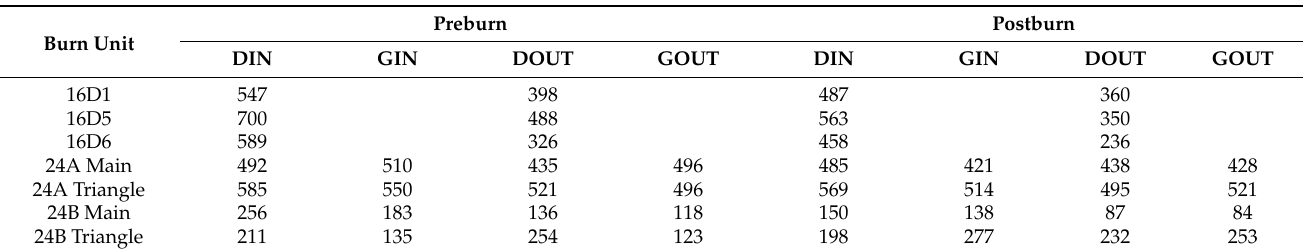
Table 3. Estimated fuel loading (g/m 2 ) from digitized and ground truth samples from inside digitized sparkleberry